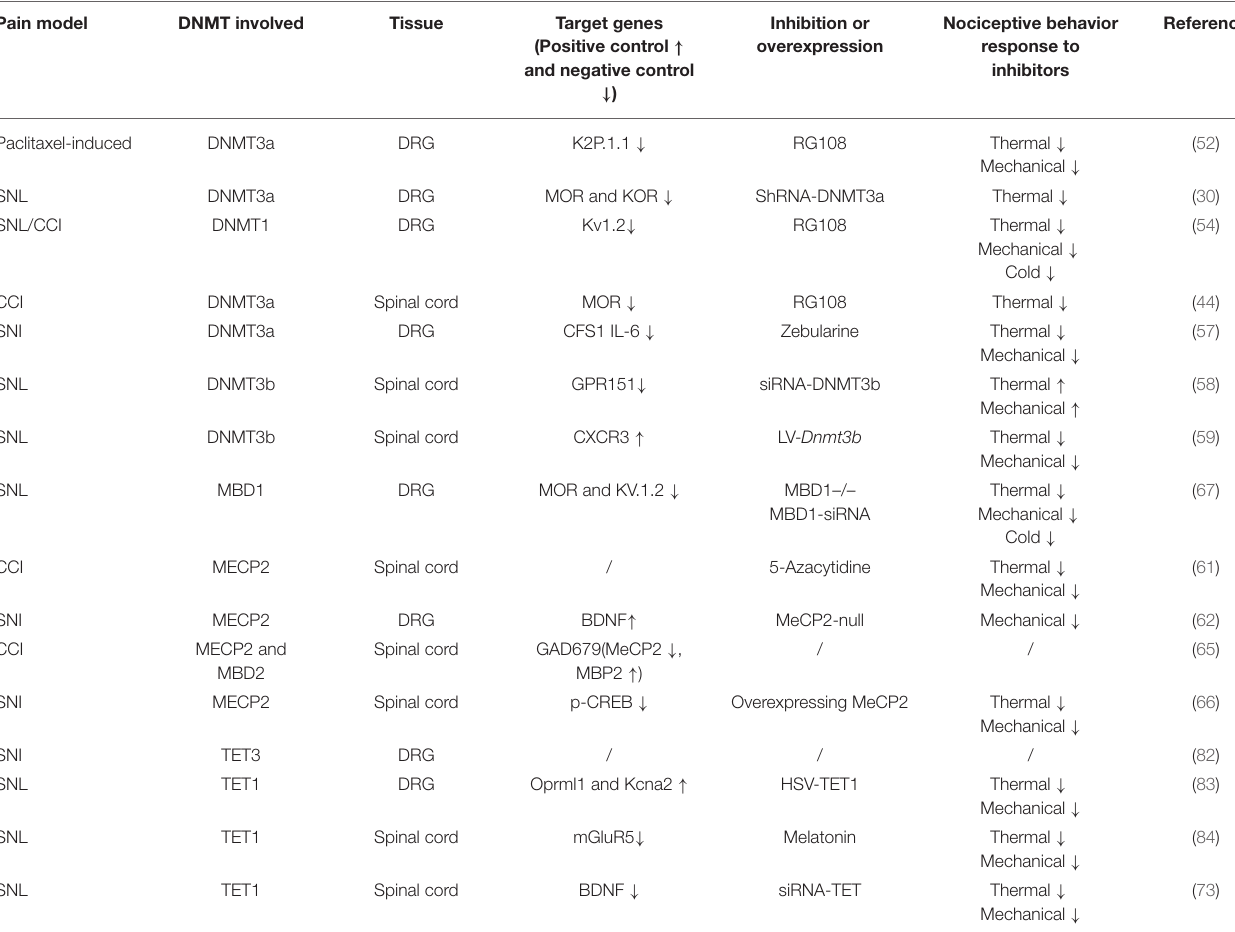
TABLE 1 | Roles of DNMT, MBD, and TET proteins in neuropathic pain (NP) in rodent models. Pain